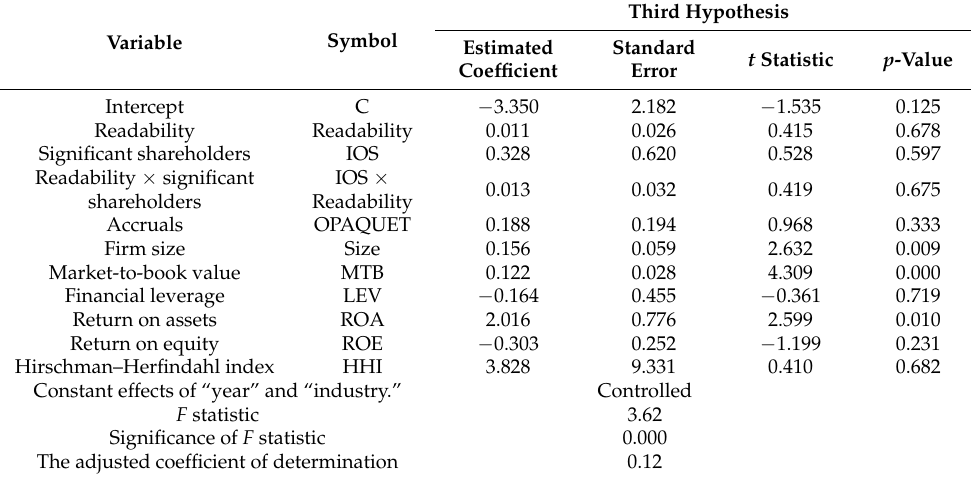
Table 6. Results of the third hypothesis test.